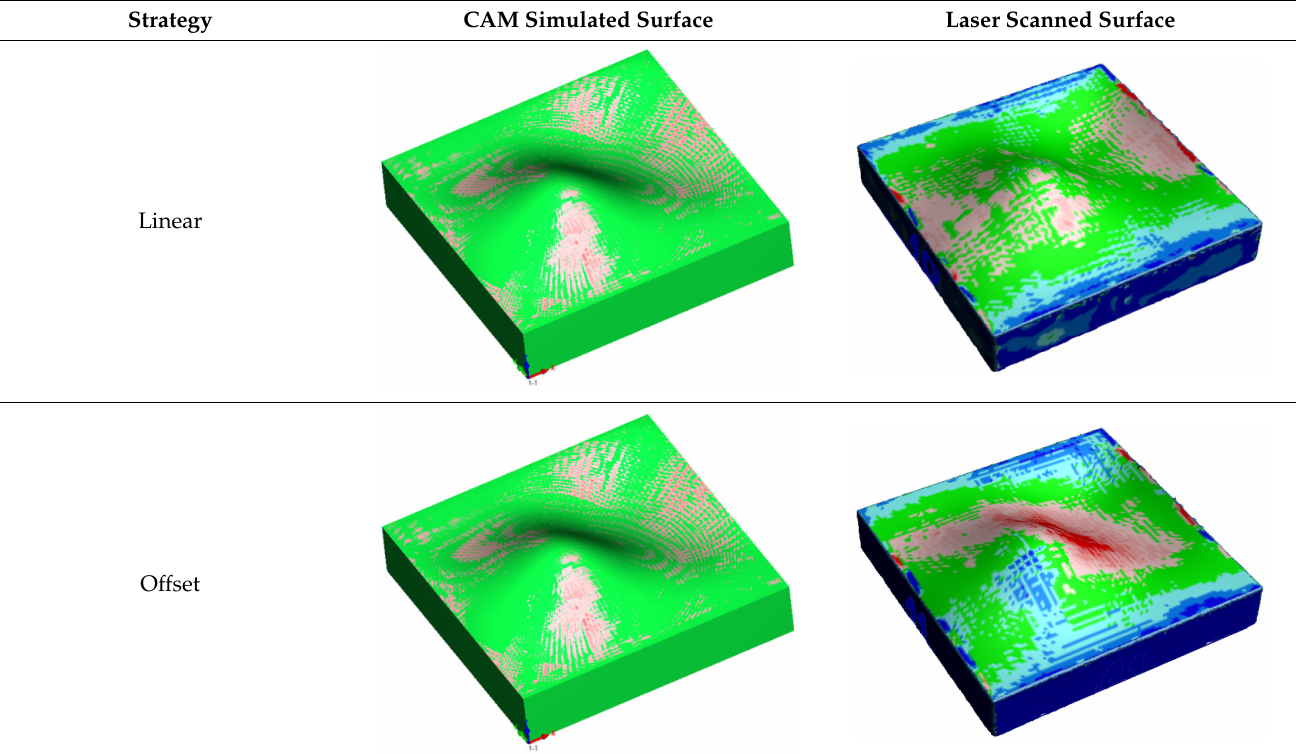
Table 3. Comparison of simulated and laser scanned surfaces of samples made by 5-axis